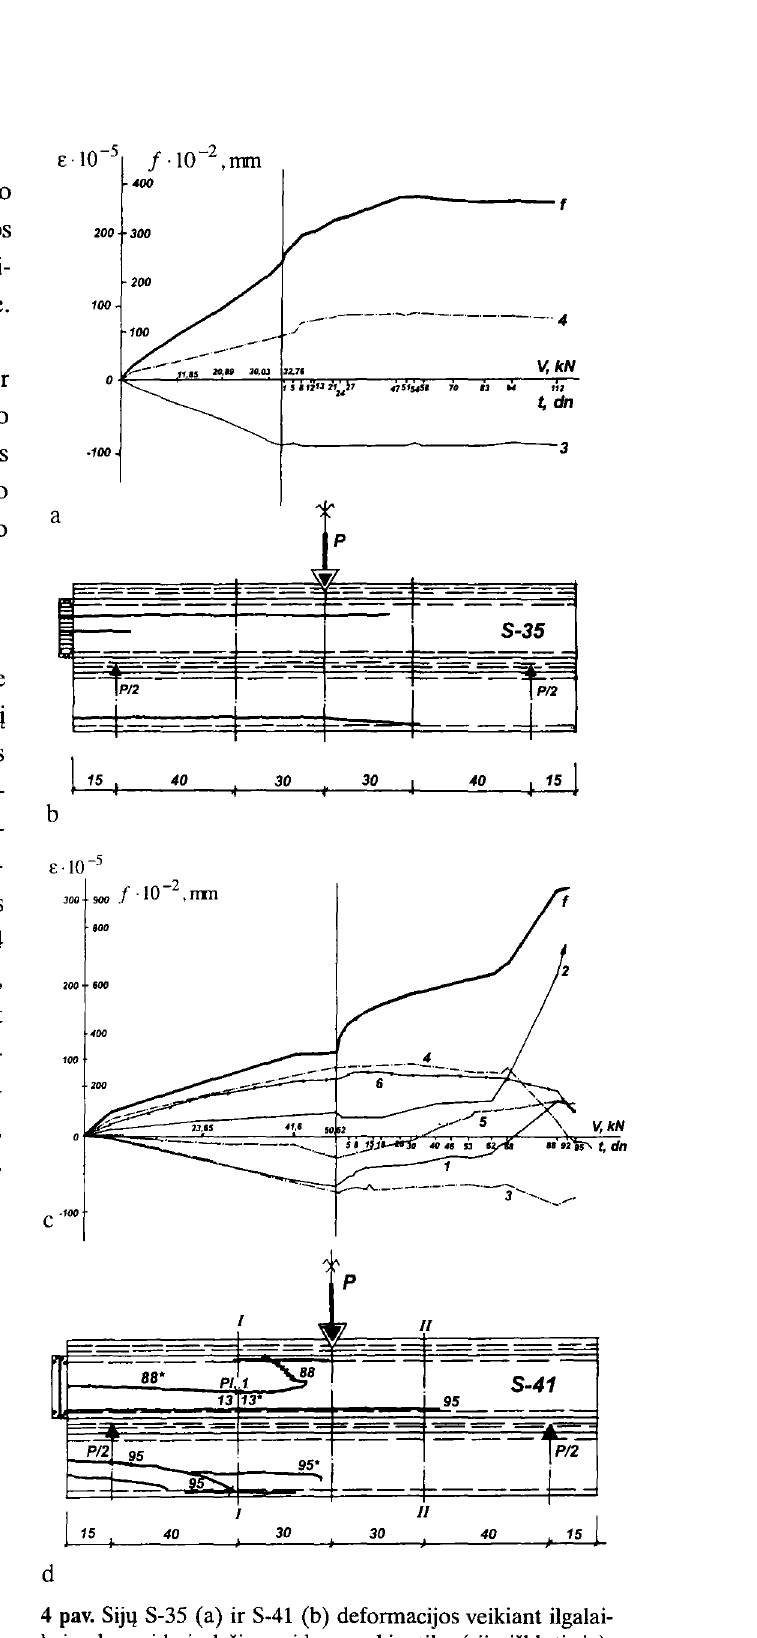
176 - armatUros santykines deformacijos (In. 17 ln. 6); f - sijos vidurio ilinkis, ---- - iklijuoti armatiiros strypai Fig 4. Strain of the beams S-35 (a) and S-41 (b) under a long-term loading (lay-out of the beams) and kinetics of cracking: 176 strain of steel reinforcement (In. 17 ln. 6); f - deflection of the beam in the middle, ____ steel reinforced bars, glued in